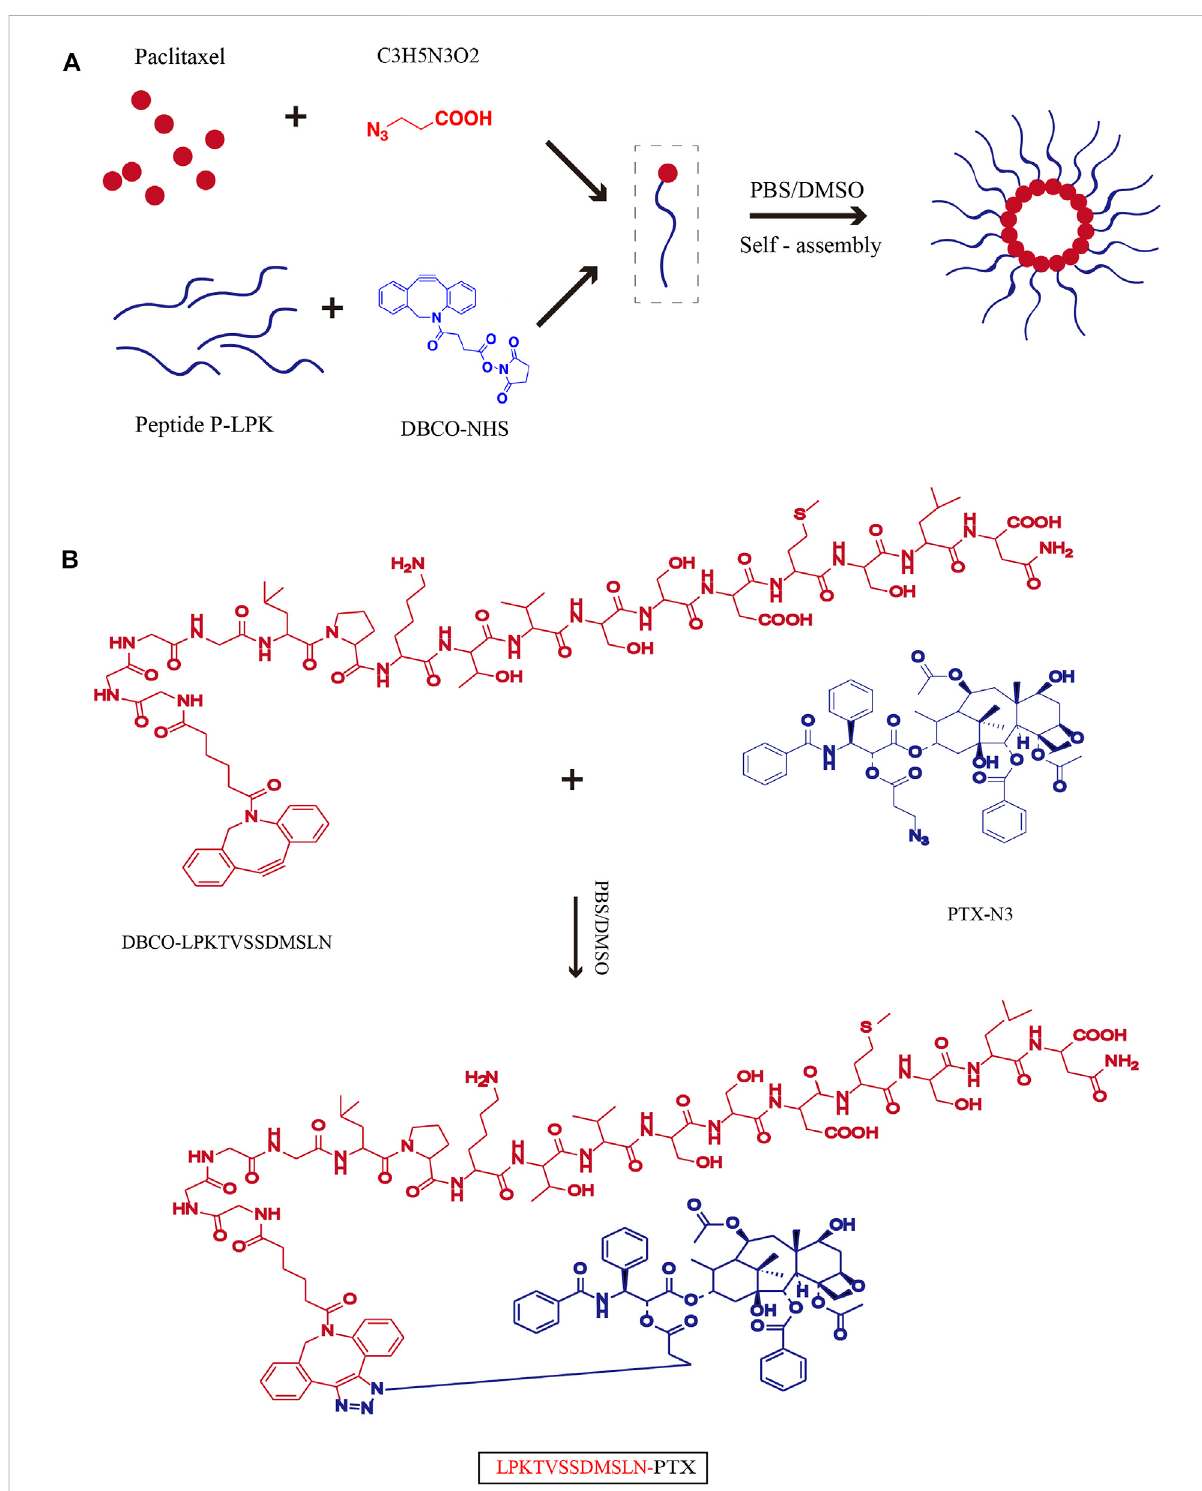
FIGURE 1 Schematic of the synthesis of LPK-PTX NPs. (A) Chemical Structure of LPK-PTX conjugate and schematic of the structure of LPK-PTX NPs. The peptide LPK was conjugated to PTX by a linker. Attachment of the hydrophobic drug PTX triggers self-assembly of the peptide LPK into spherical nanoparticles with a drug-rich (Red circles) core surrounded by a hydrophilic peptide corona (Blue chains). (B) PTX was fi rst reacted with 3- azidopropanoic acid at the 2 ′ -OH position of PTX to introduce an azide-carbonyl functional group. The peptide P-LPK was modi fi ed with DBCO. Then PTX-N3 and DBCO-P-LPK was conjugated by click